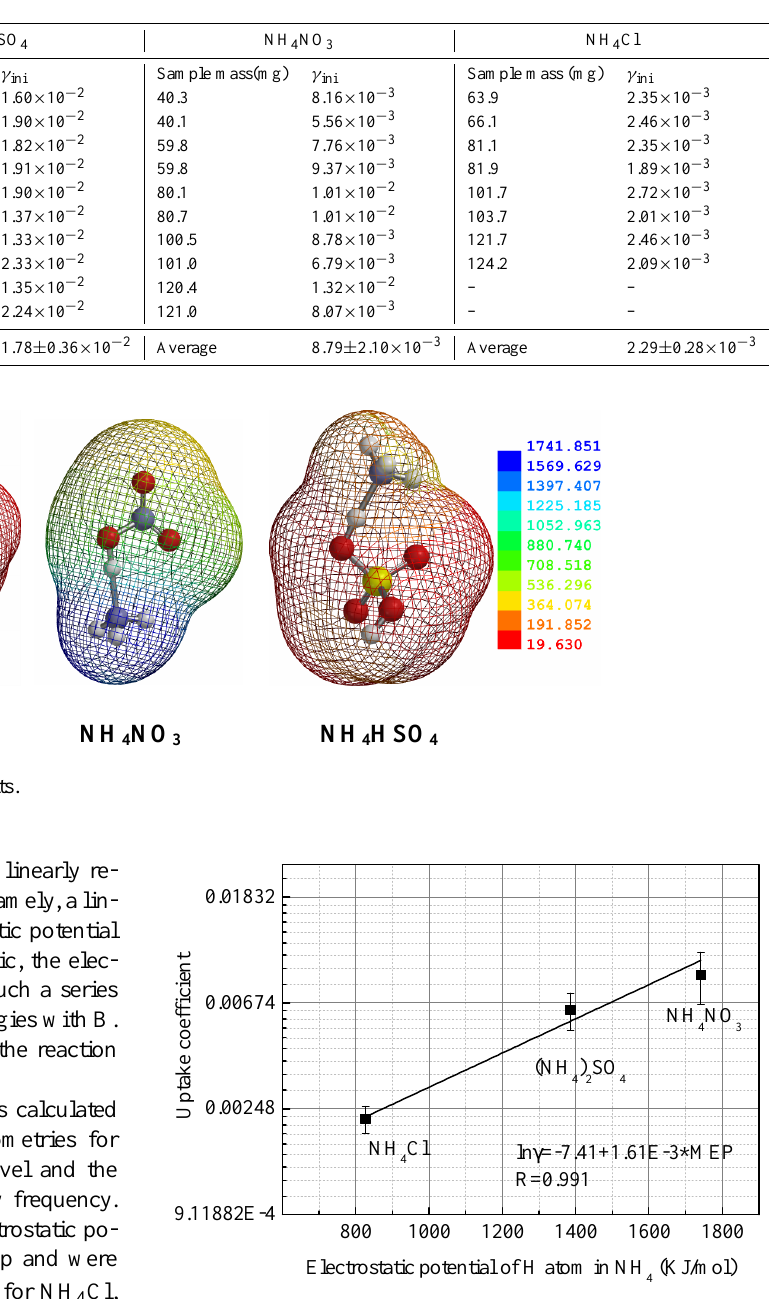
Fig. 6. Relationship between uptake coefficients of MA onto ammonium salts and the electrostatic potential of H atom in NH 4+ . 697 first step for the heterogeneous reactions between MA and MA onto the NH + group, in which H atom should be the 4 active